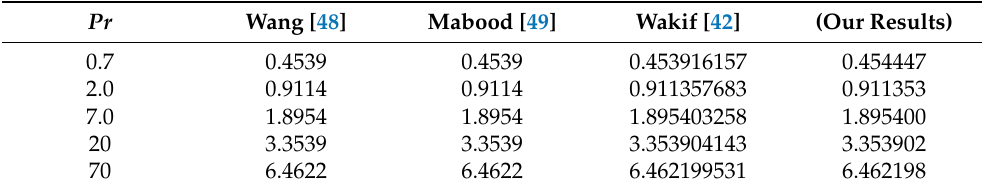
(cid:113) 1 n + 1 ( f (cid:48)(cid:48) ( 0 ) + 2 x C fx = − 2